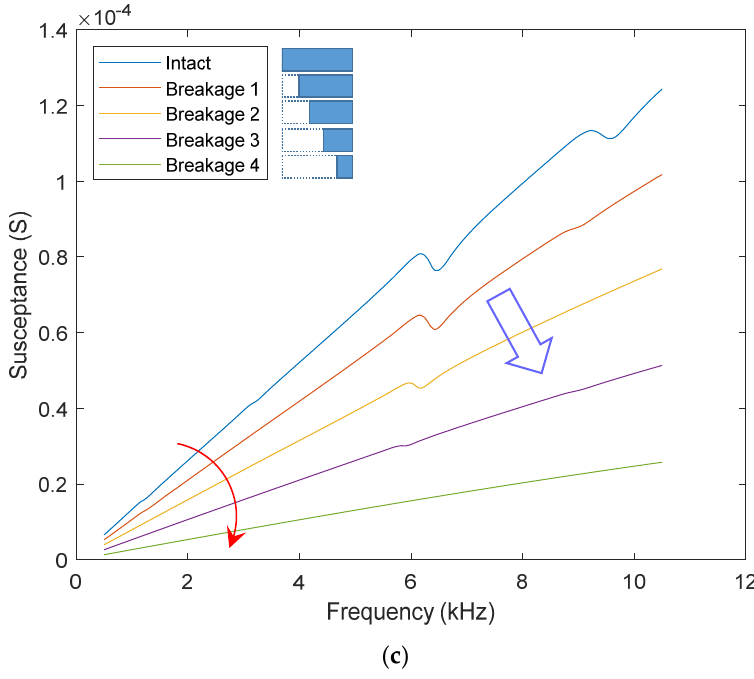
Figure 10. Impedance response: PZT breakage simulation. ( a ) Resistance; ( b ) Reactance; ( c ) Suscep ‐ tance.